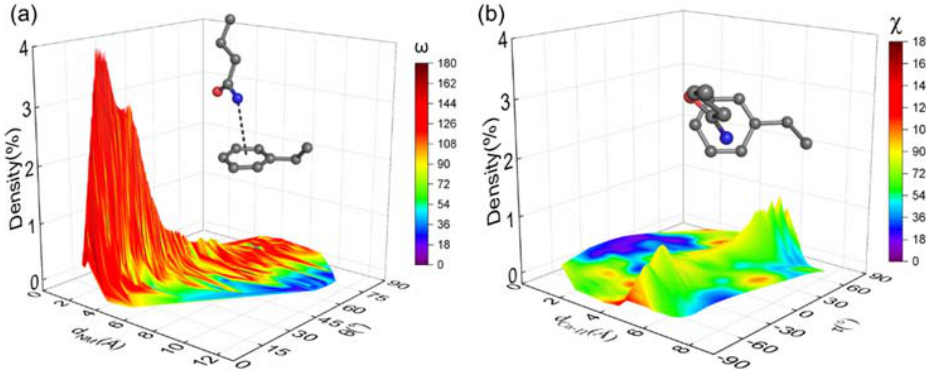
Figure 3. Molecular dynamics simulation of the collagen-like peptide GPQGFO. The geometric parameters of the Q-F pair between the leading and middle chain were extracted from the trajectory and plotted into three-dimensional density maps. ( a ) Conformation occurring percentage is plotted against d NM and θ . The surface is color-coded with ω . ( b ) Conformation occurring percentage is plotted against d C γ - π and τ . The surface is color-coded with χ . The color scales are located on the right. Insets of ( a, b ) show the most occurring conformations.